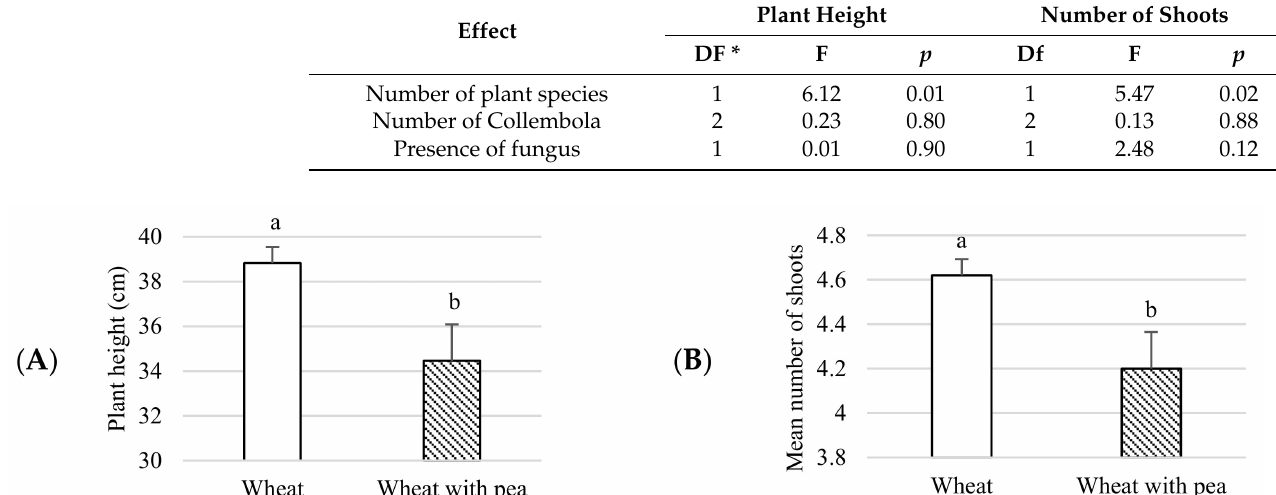
Table 2. The height of the plant and the number of shoots to the number of plant species (two variants), the number of individuals from Collembola (3 variants), and the presence of Fusarium